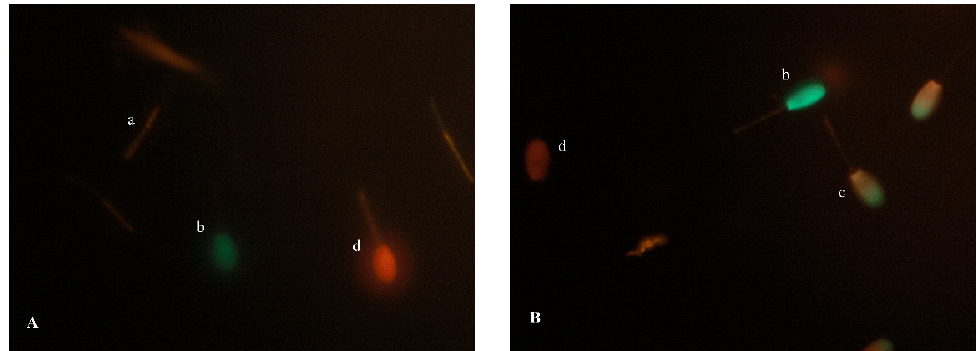
Figure 3. ( A , B ) Red deer sperm stained with the fluorescent combination of JC-1 and YOPRO/PI fluorochromes under a fluorescence microscope: ( a ) Non-apoptotic cells, yellow/orange fluorescence in midpiece (YOPRO − /PI − ). ( b ) Apoptotic cell, green fluorescence in head region (YOPRO + /PI − ). ( c ) Moribund/dying sperm, cell with dual fluorescence green and red in head region (YO-PRO + /PI + ). ( d ) Dead sperm, red fluorescence in head region (PI + ). Magnification 600×. DNA integrity was assessed with acridine orange (AO; Life Technologies Ltd., Grand